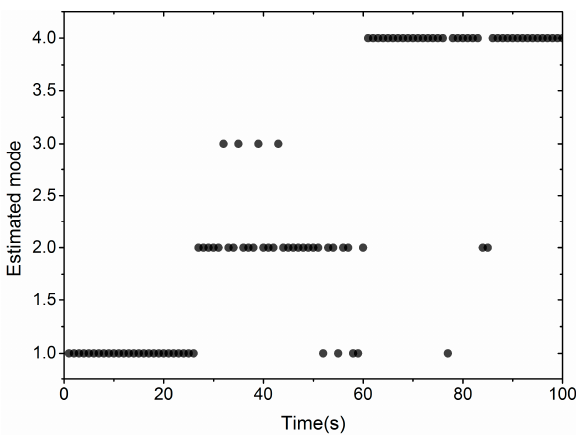
Figure 9. The mode recognition results in simulation 2.